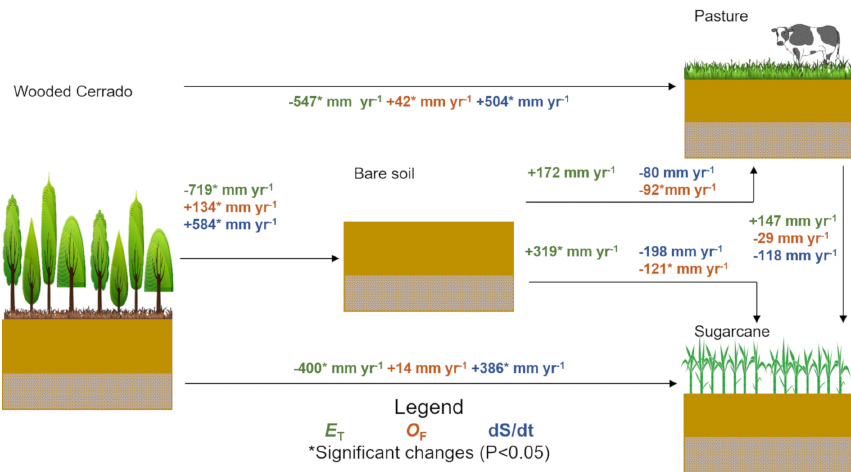
Figure 5. Annual observed means (2012–2016) of hydrological trade-offs related to evapotranspiration ( E T ), surface runoff ( O F ) and water balance residual (d S/ d t ) due to potential LCLUC found in southeastern